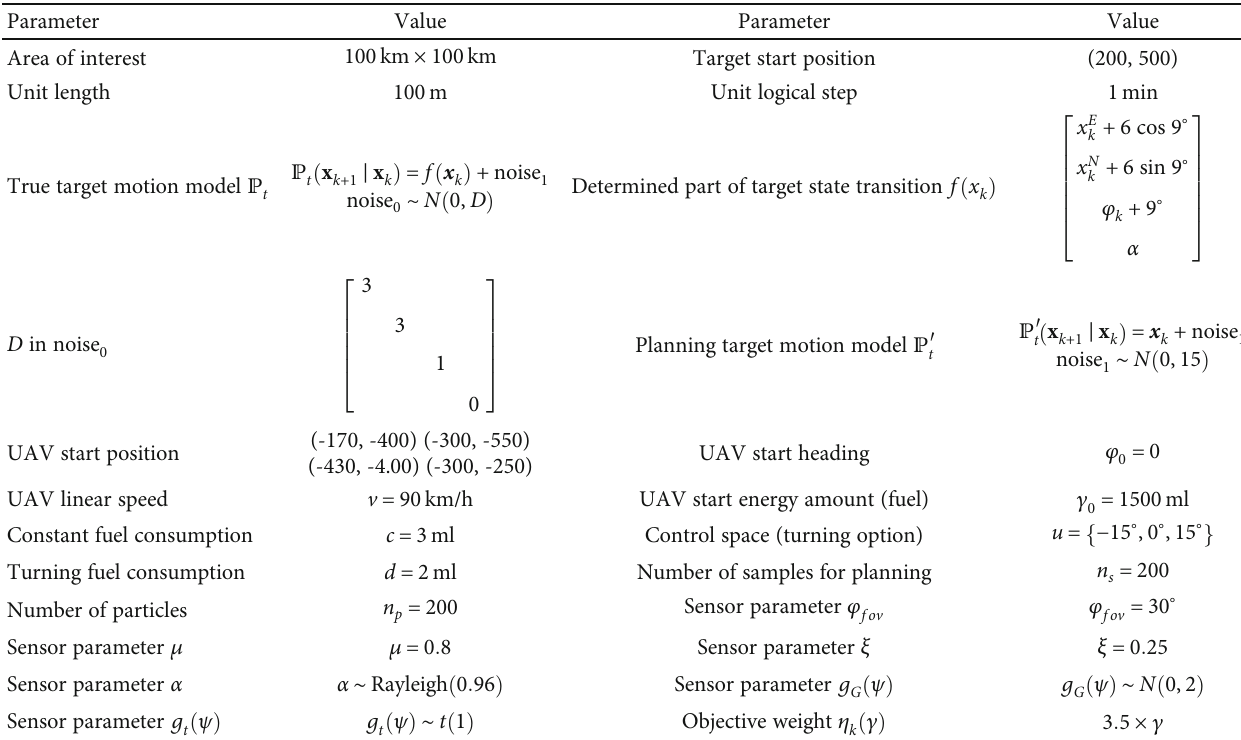
Table 1: Simulation